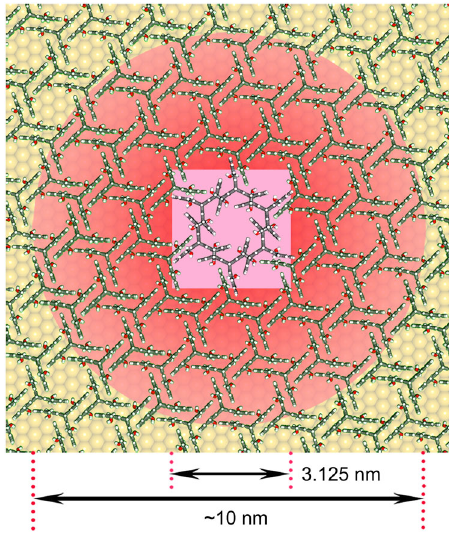
Fig. 4 Schematic illustration of a monomer 1 packing model on Au(111). This model contains a single imaging pixel (pink square), a growth nucleus (reacted unit, highlighted in pink in the center), and the strongest hotspot area (red